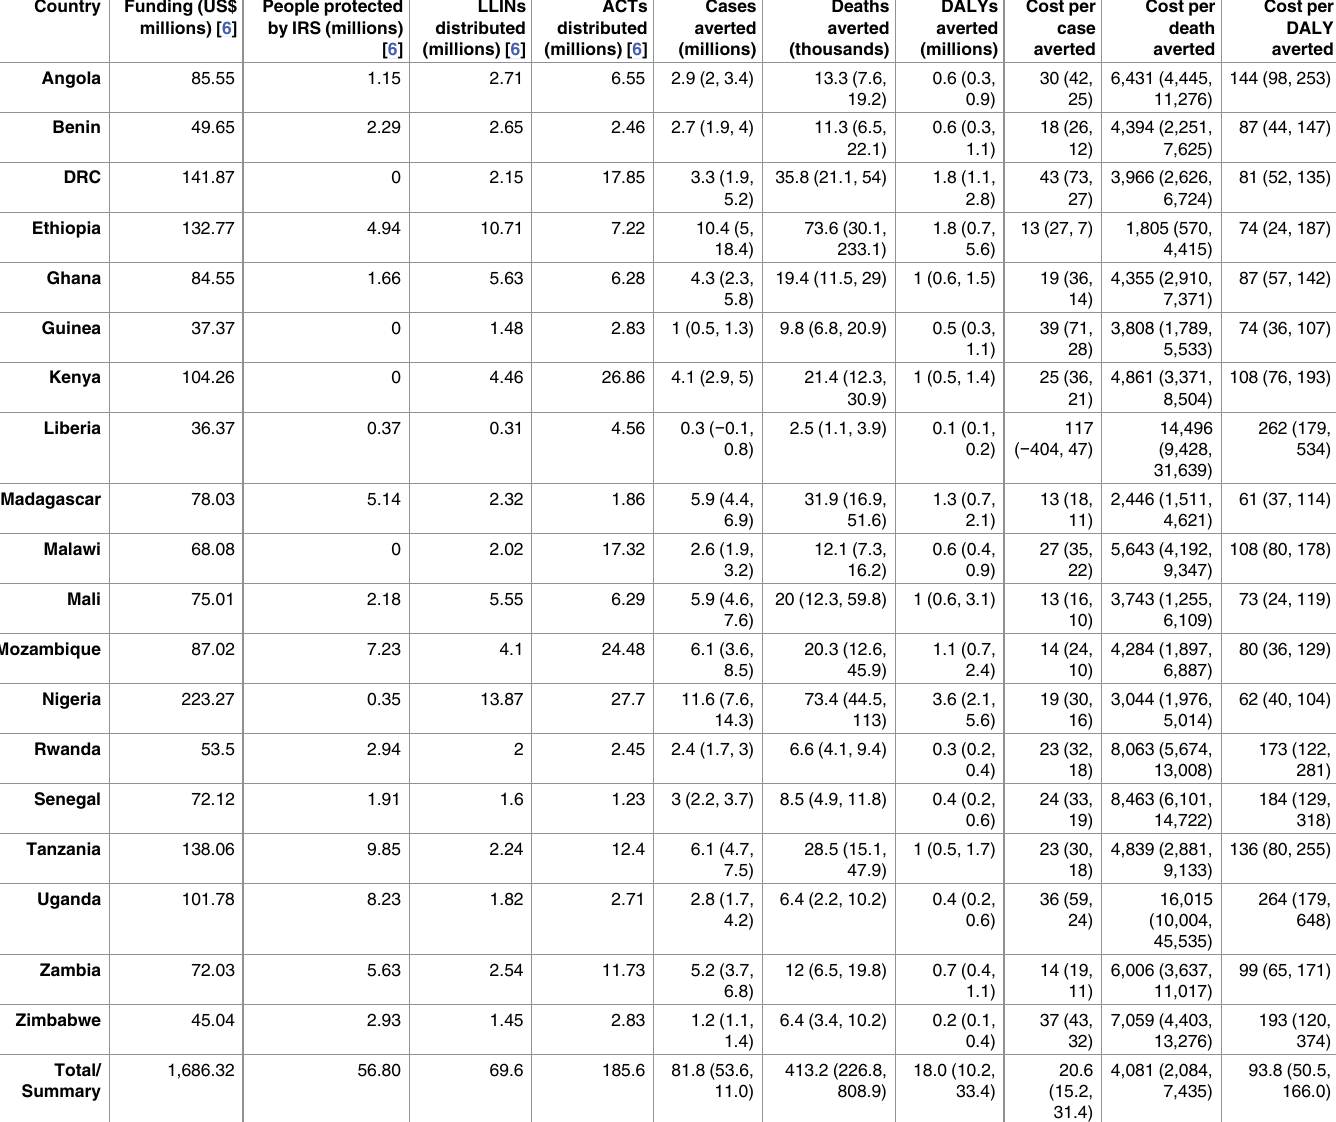
Table 1. Summaryof PMI support and estimated impact for 19 focus countries (2013–2015). Country Funding (US$ People protected millions) [6] by IRS